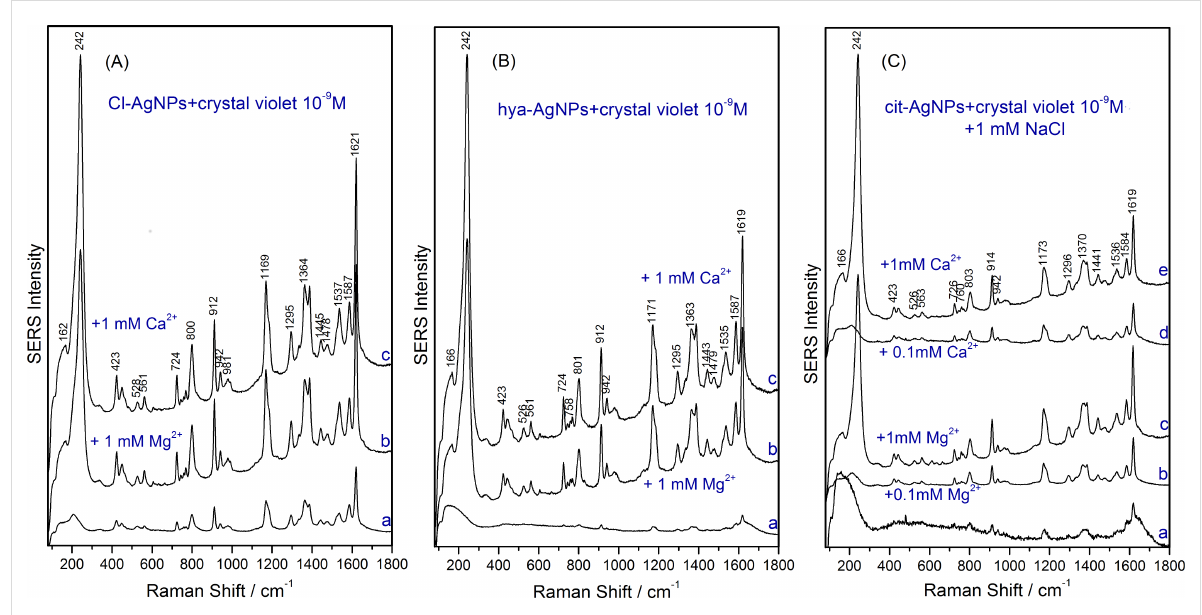
Figure 6: SERS spectra of 10 − 9 M crystal violet recorded using the following as substrates: (A) Cl-AgNPs (a), Cl-AgNPs and 1 mM MgSO 4 (b), 1 mM Ca(NO 3 ) 2 (c); (B) hya-AgNPs (a), hya-AgNPs and 1 mM MgSO 4 (b), 1 mM Ca(NO 3 ) 2 (c); (C) cit-AgNPs+1mM NaCl (a), cit-AgNPs+1mM NaCl and 10 − 4 M MgSO 4 (b), cit-AgNPs+1mM NaCl and 1 mM MgSO 4 (c), cit-AgNPs+1mM NaCl and 10 − 4 M Ca(NO 3 ) 2 (d), cit-AgNPs+1mM NaCl and 1 mM Ca(NO 3 ) 2